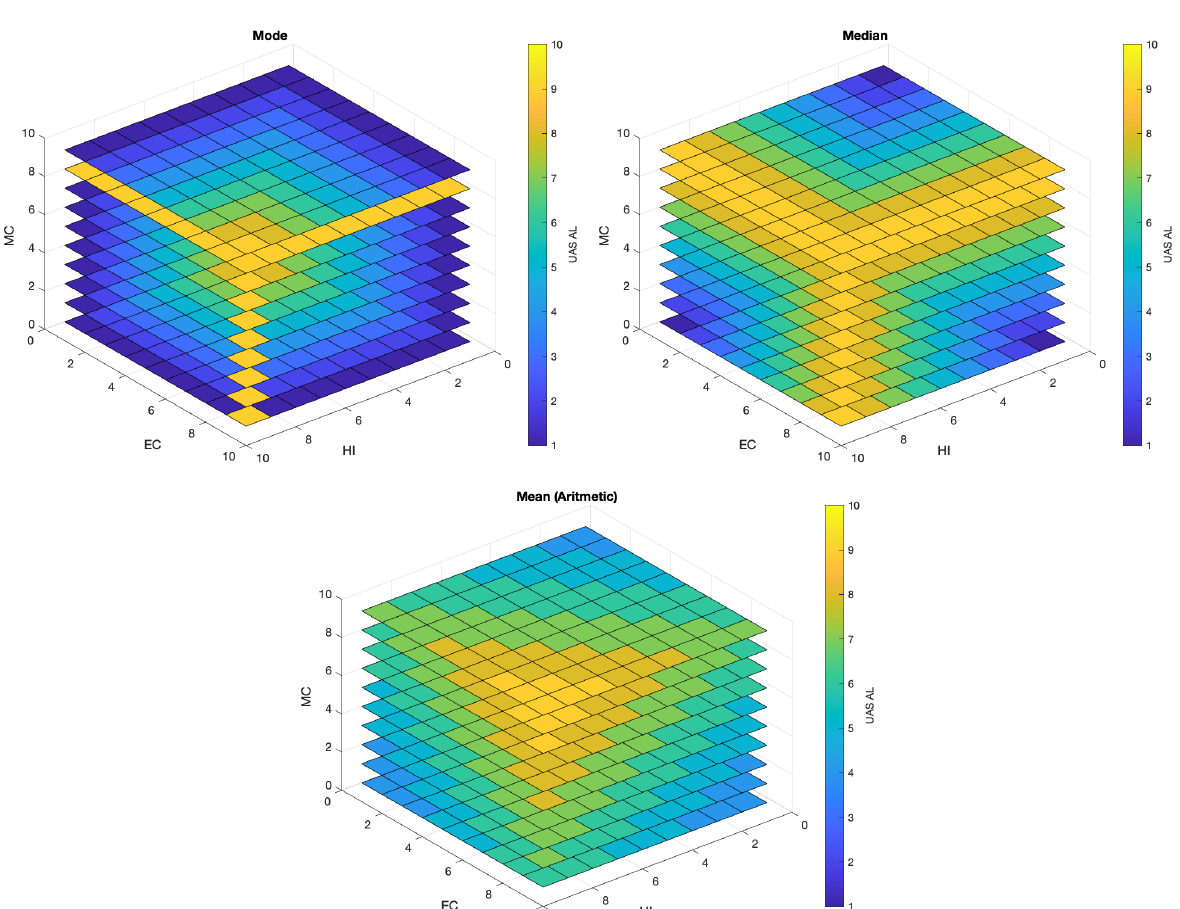
Figure 5. Estimation of the UAS AL using mode, median and mean (arithmetic). We note the arithmetic mean provides good balance between over/under